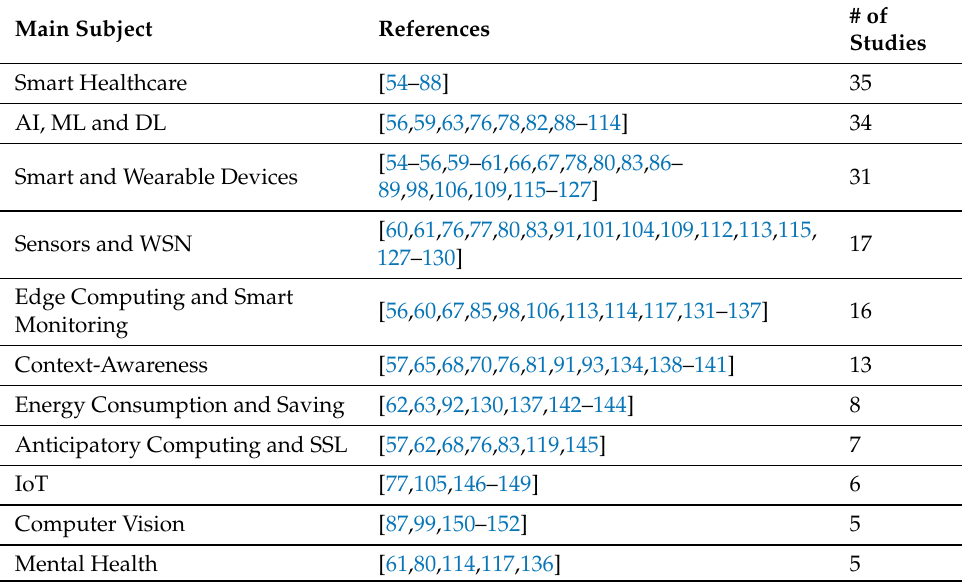
Table 6. The main subjects along with the references to their related papers.